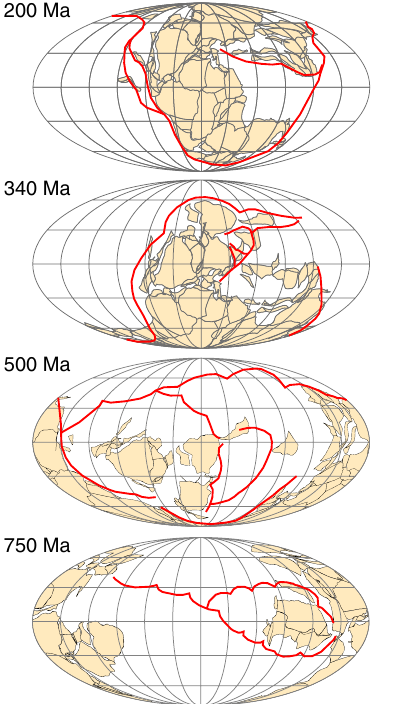
Fig. 2 Past subduction zones shown in simpli fi ed PALEOMAP reconstructions. Subduction zones in red. See ‘ Methods ’ and Supplementary Fig. 3 for more information